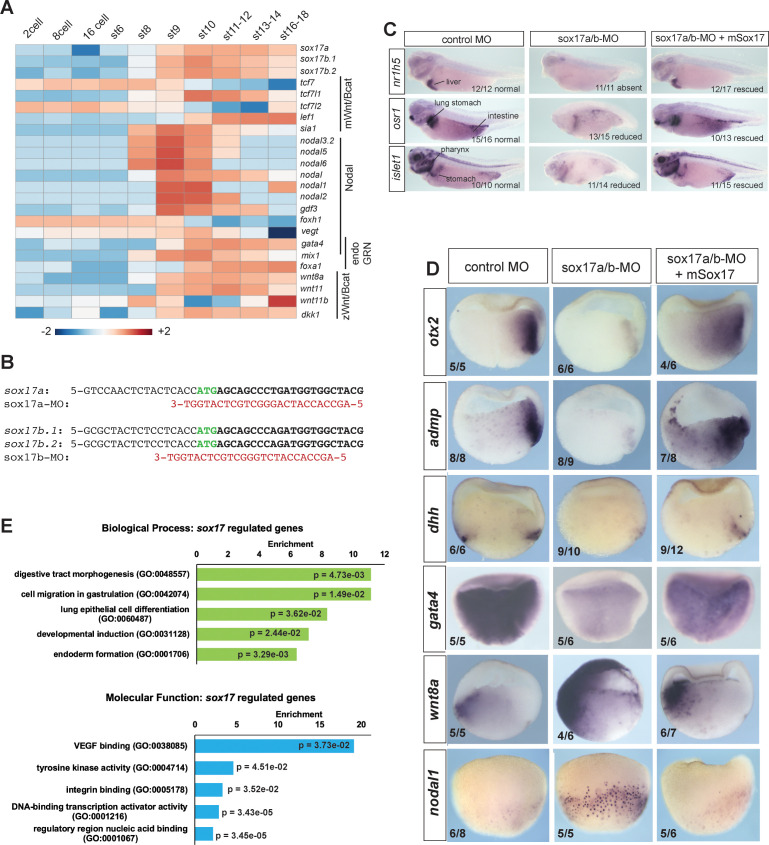
Characterization of Sox17-MO embryos and Sox17-regulated transcriptome.(A) Temporal expression of key endoderm GRN transcripts (GSE65785; Owens et al., 2016). (B) Sequence alignment of antisense sox17a-MO and sox17b-MO (red) with 5’ end of Xenopus tropicalis sox17a, sox17b.1 and sox17b.2 mRNAs (black) spanning the ATG translation start (green). (C) In situ hybridization of markers for the liver (nr1h5), stomach, lung, intestine and pharynx (osr1 and islet1) snowing that co-injection of mouse Sox17 RNA rescues gut development in sox17-MO embryos at the tailbud stage. (D) Additional validation of gastrula stage transcripts downregulated (otx2, admp, dhh and gata4) or upregulated (wnt8 and nodal1) in sox17-MO embryos and rescue by co-injection of mSox17. (E) GO term enrichment analysis of Sox17-regulated genes showing fold enrichment by Fisher’s exact test with p-values adjusted to 5% FDR for multiple testing correction.